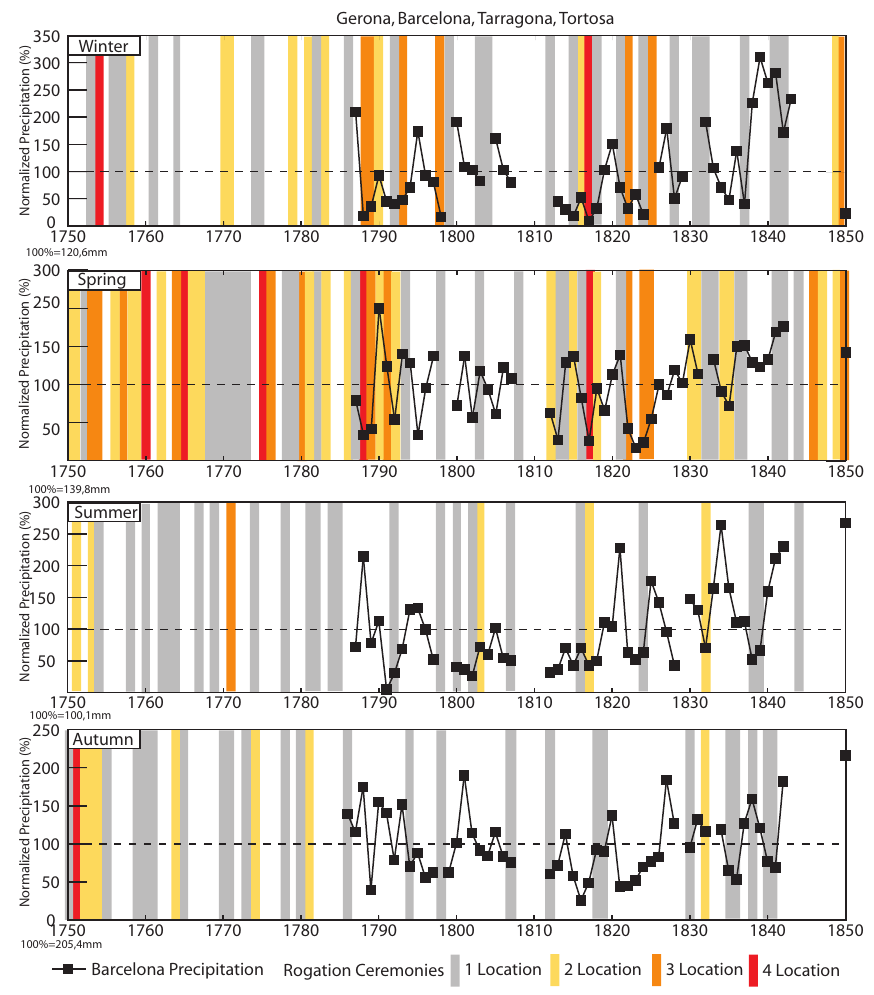
Fig. 2. North-eastern coast region. Line: seasonal anomaly of the precipitation in Barcelona. Bars: number of sites where rogations were celebrated (red: 4 sites, darker orange: 3 sites; yellow: 2 sites; and grey: 1 site; Gerona, Barcelona, Tarragona and